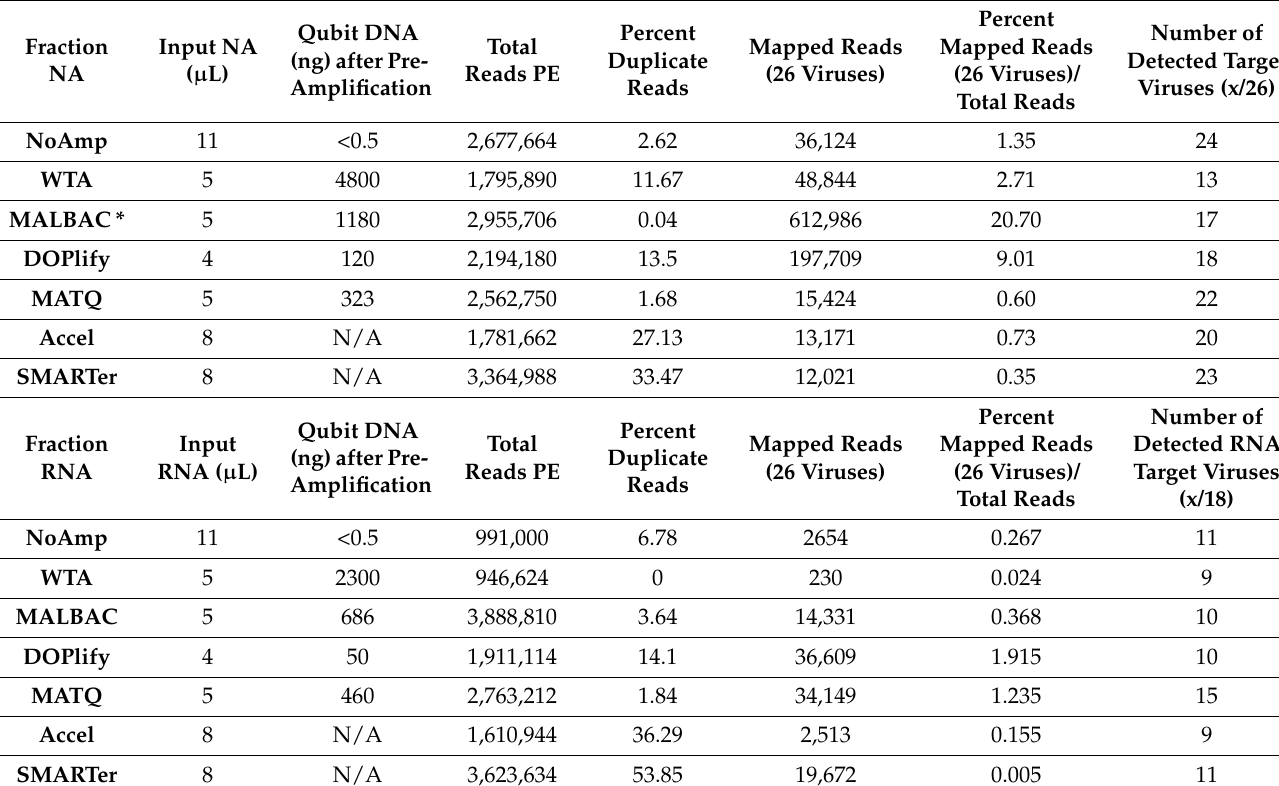
Table 2. DNA yields after pre-amplification and detailed sequencing data from crude VMRP. N/A Not applicable. * 12 cycles of quasi-linear pre-amplification and 25 cycles of